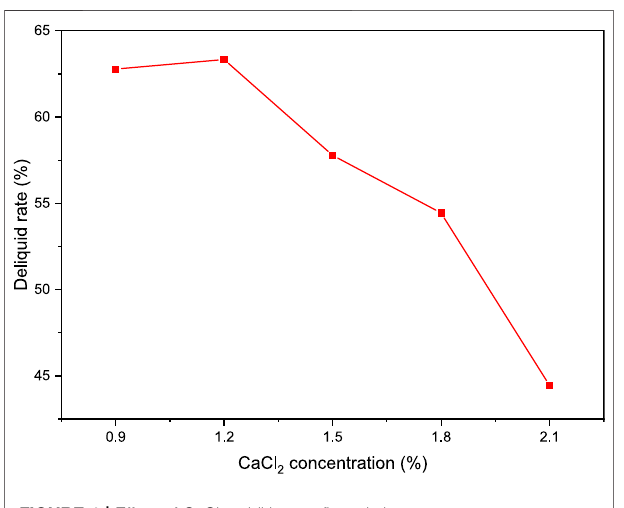
FIGURE 1 | Effect of CaCl 2 addition on fl occulation. FIGURE 2 | In fl uence of different pH value on fl occulation